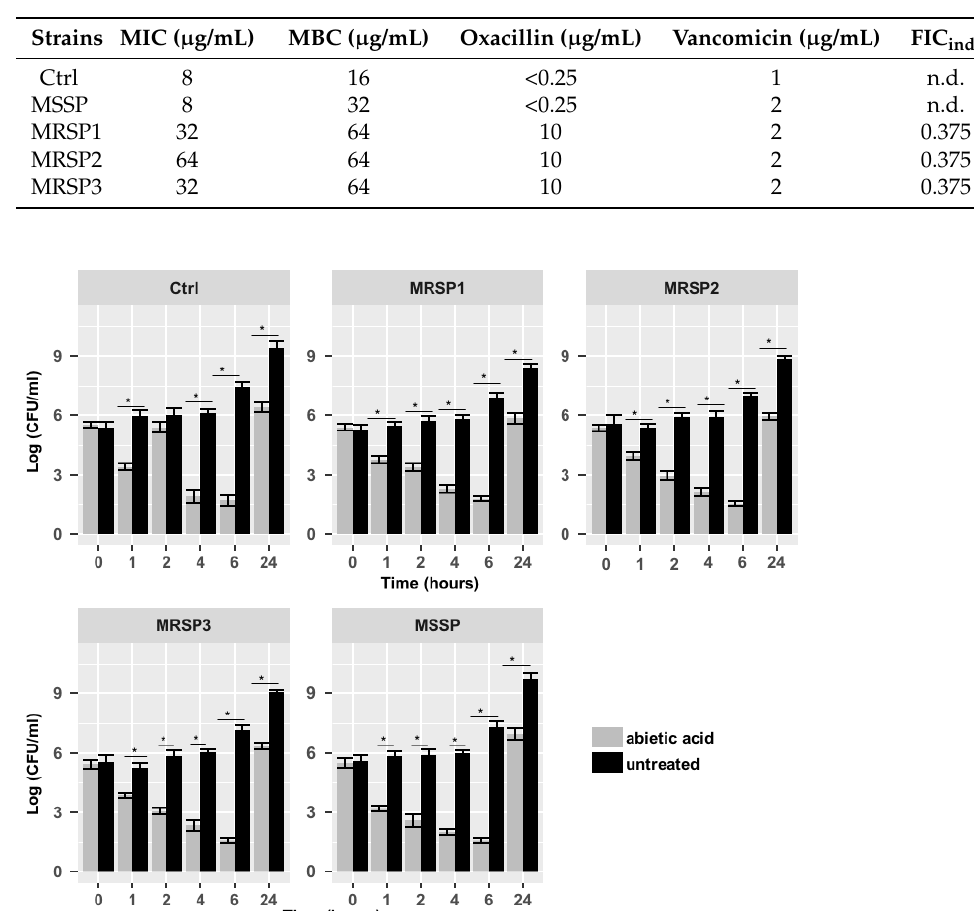
Table 2. Minimal inhibitory concentration (MIC90), minimal bactericidal concentration (MBC) and fractional inhibitory concentration (FIC index ) values of abietic acid on selected bacterial strains. n.d. = not determined. Each result is representative of three independent experiments per- formed in triplicate.